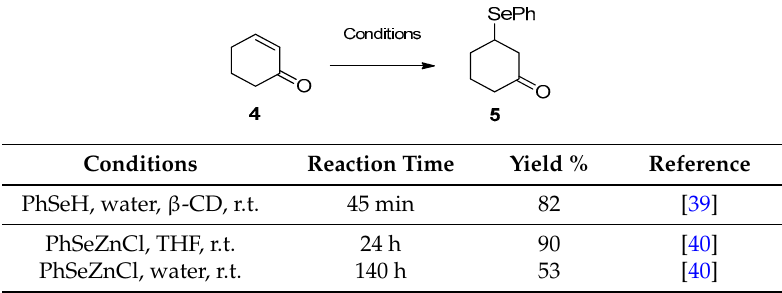
Table 1. Michael-type addition to enones.